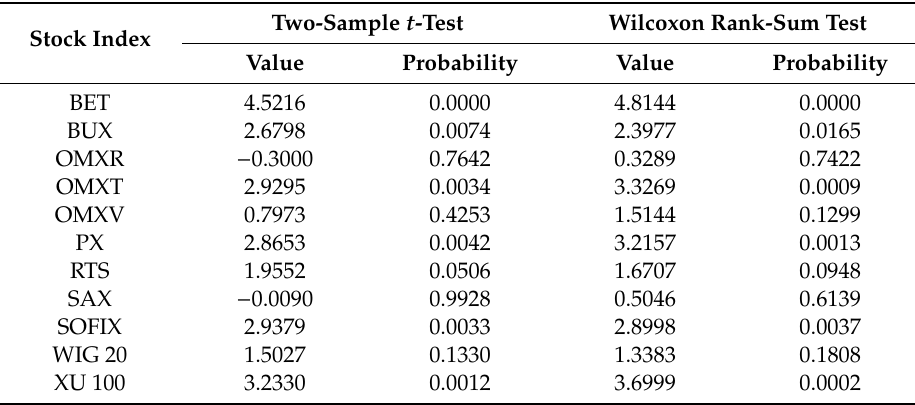
Table 3. Results of the statistical significance tests—Turn of the month window (2 + 2).